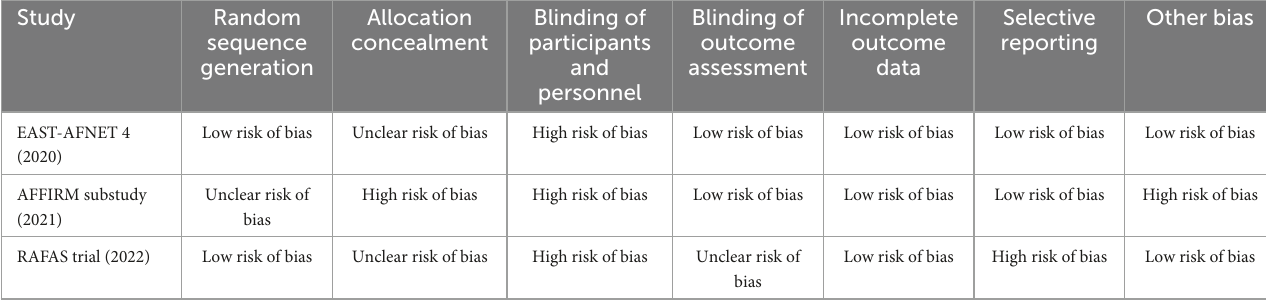
TABLE 2 (B) Quality assessment of randomized control trials by Cochrane collaboration’s tool.